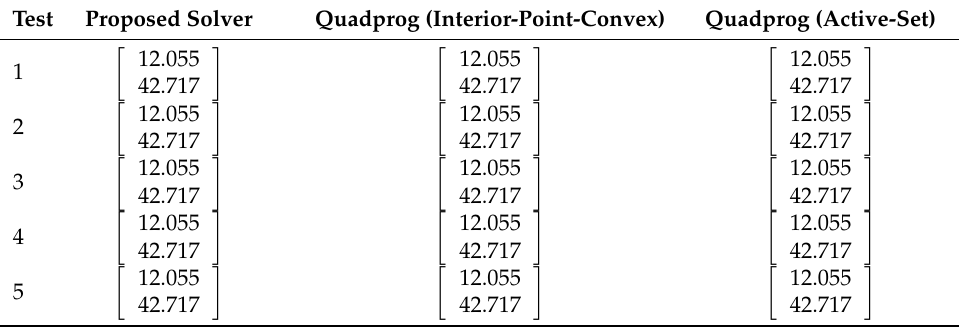
Table 3. Comparison of the obtained optimum